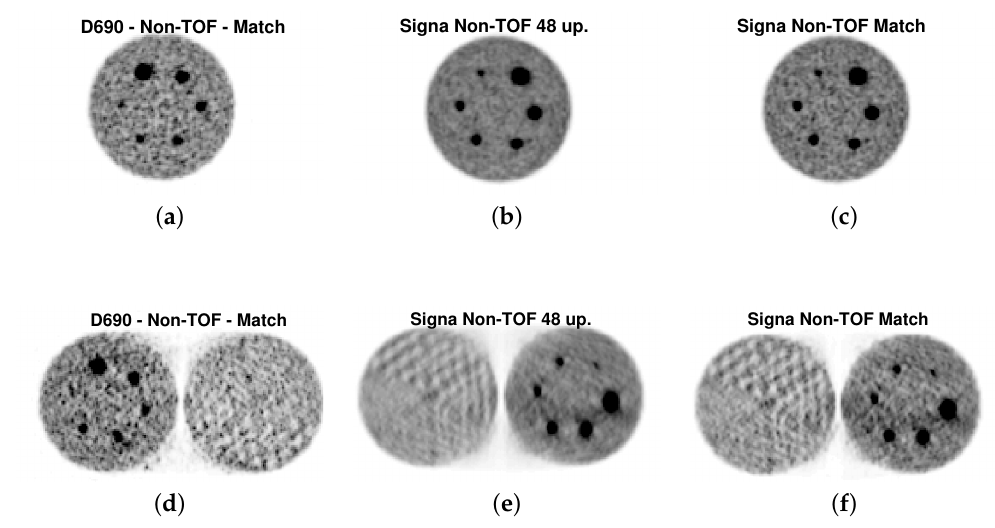
Figure 5. Non-TOF Reconstructions of the phantoms in different conditions. Upper: Single acquisi- tions. Matched non-TOF reconstructions for D690 not shown for clarity Lower: Double acquisition, HCR only for SIGNA shown for clarity. Left ( a , d ): D690 acquisitions, 48 updates. Center ( b , e ): SIGNA acquisitions, 48 updates. Right ( c , f ): SIGNA acquisitions, 32 updates according to the proposed